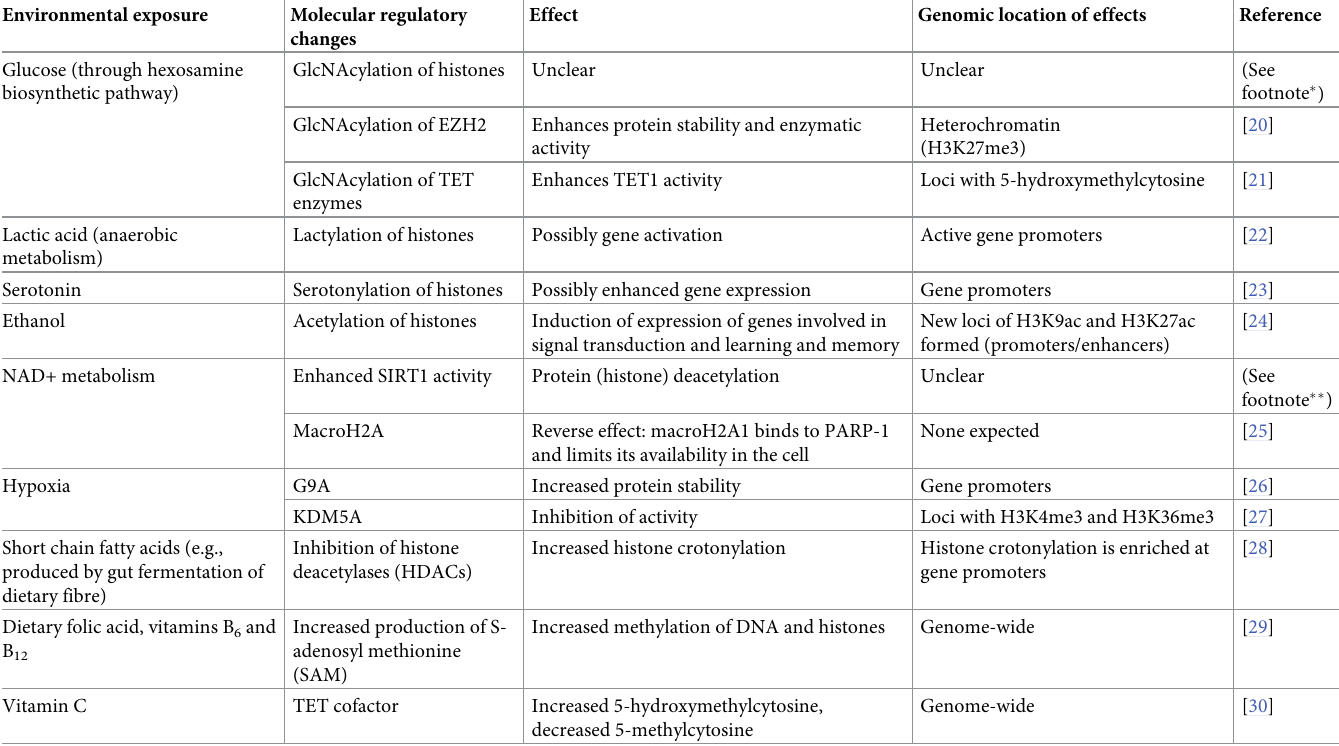
Table 1. Examples of environmental exposures that directly affect molecular regulators of